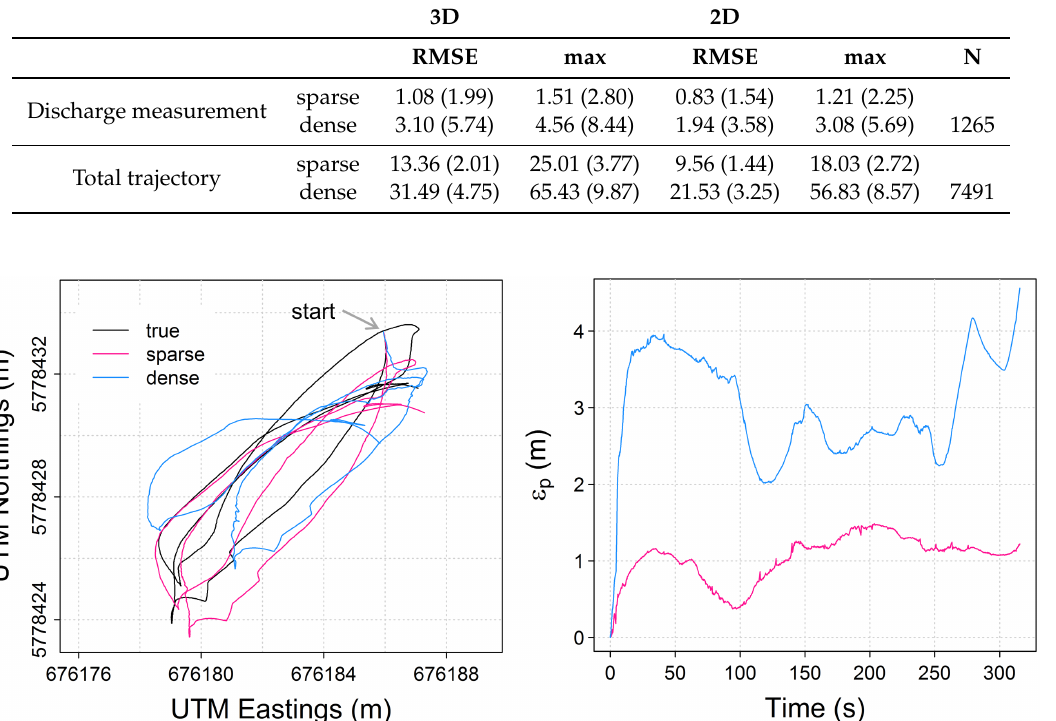
Figure 6. Position estimates ( Left ) and accumulation of 3D position error ε p ( Right ) for a discharge measurement track of four consecutive river